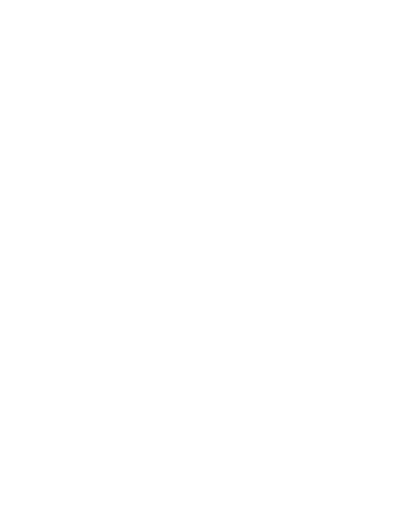
Figure 3. Geogrids with different mesh sizes after